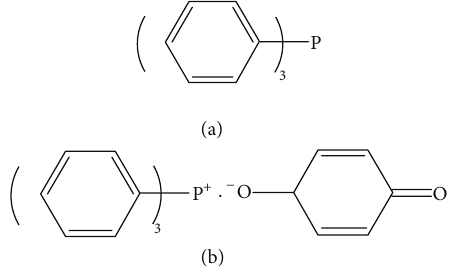
Scheme 2: The chemical structure of the (a) TPP and (b) TPP-BQ.